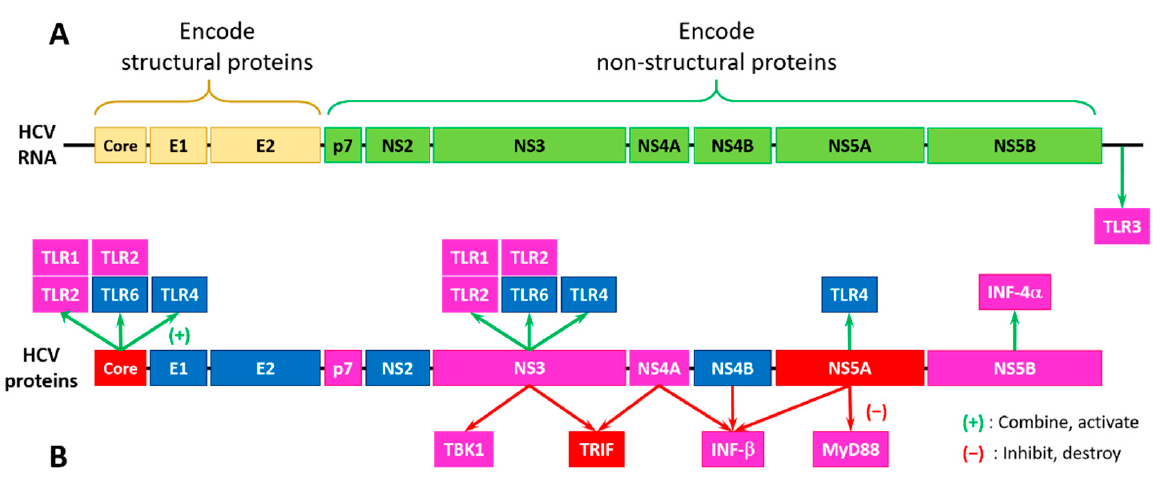
Figure 9. The organization of the HCV genome ( A ) and effects of the HCV-encoded proteins on Toll-like receptors (TLRs) and related downstream molecules ( B ). Proteins are colored based on their intrinsic disorder status, where highly disordered, moderately disordered, and highly ordered proteins are shown by red, pink, and blue colors, respectively. Proteins are classified based on the accepted strategy rooted in the percent of predicted intrinsic disorder (PPIDR) of query proteins, where proteins are considered as highly ordered, moderately disordered, and highly disordered, if their PPDR <10%, 10% ≤ PPDR < 30%, and PPDR ≥ 30%, respectively